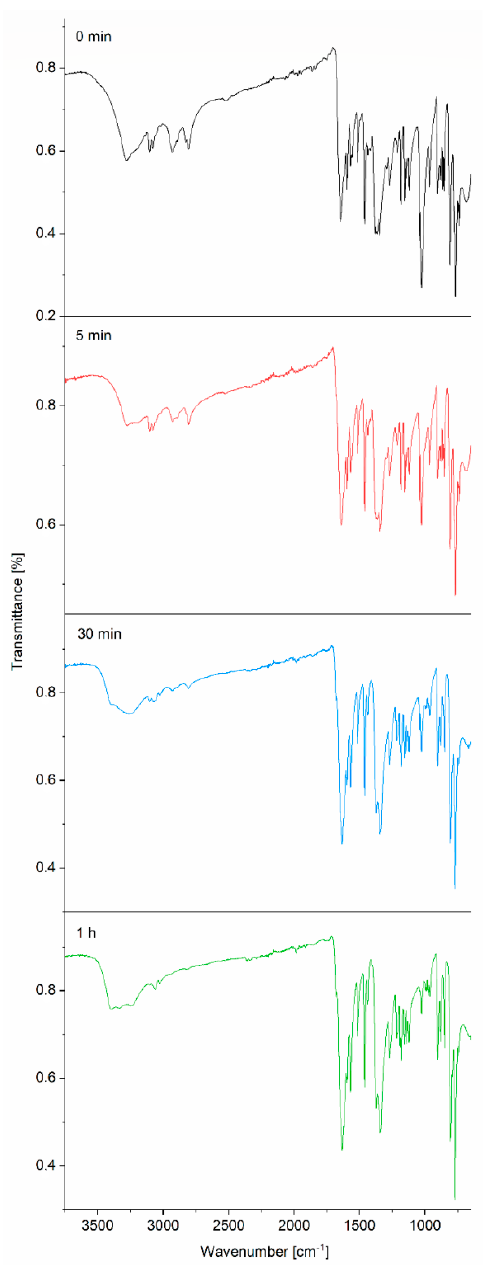
Figure 11. A time evolution of the IR spectra of [Cu(quin) 2 (CH 3 OH)] · CH 3 OH ( 1 ). Color code: black—0, red—5, blue—30 and green—60 min.